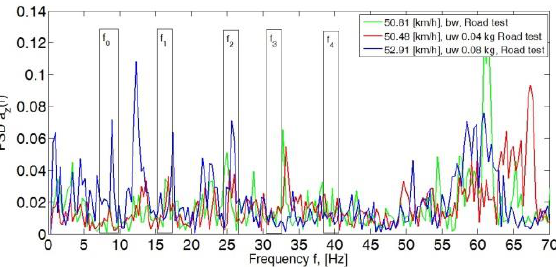
Figure 4. Power spectral density graph of the body acceleration signal for a speed of 50 km/h.